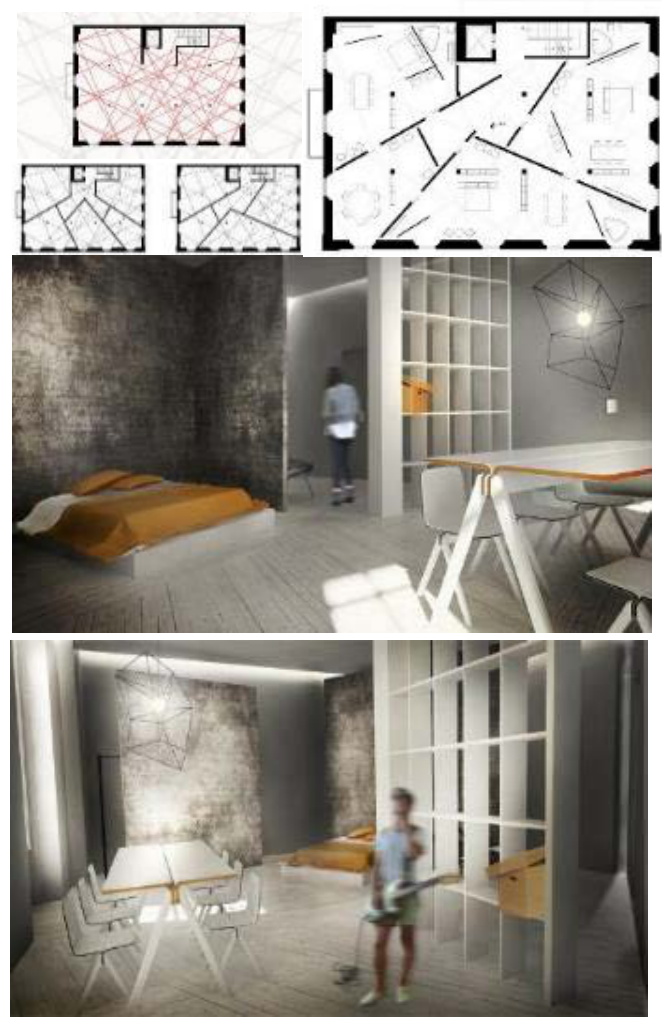
Figure 5 Photo Credit to Architect Marielena